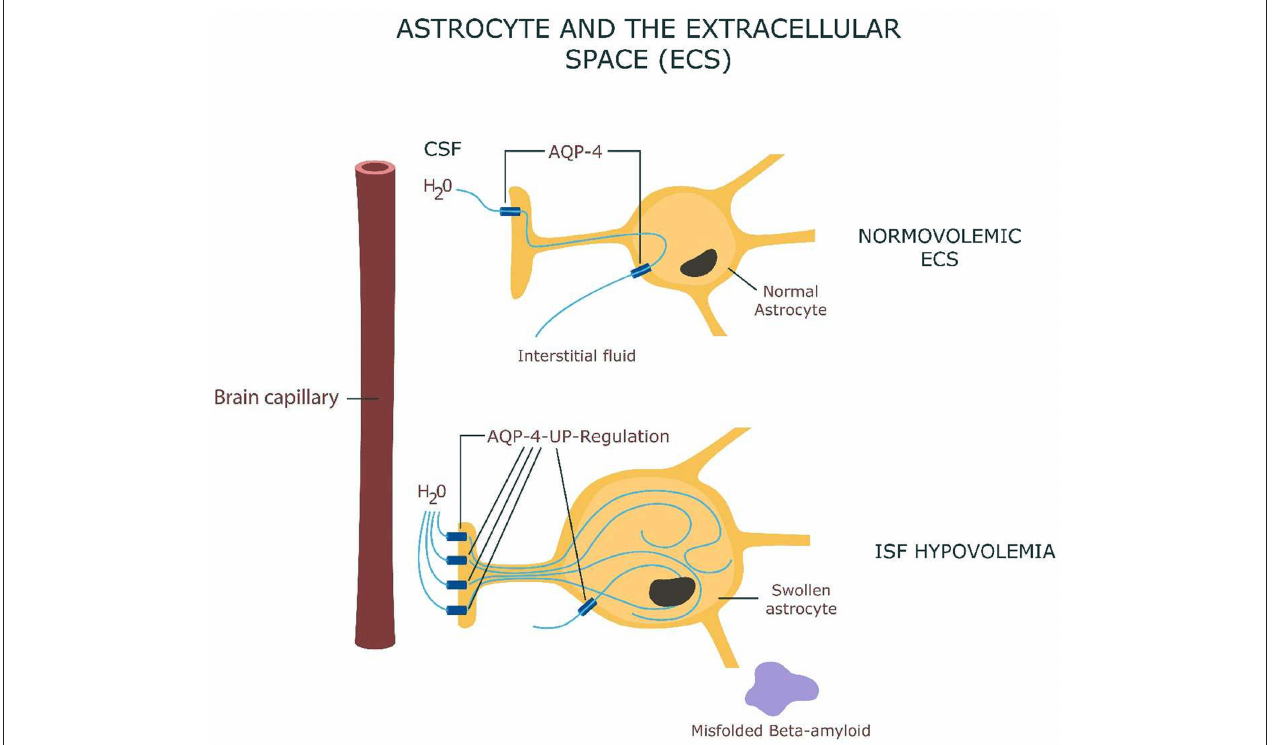
FIGURE 1 | Astrocyte swelling as a result of AQP-4 channels up-regulation with interstitial fluid hypovolemia and beta-amyloid misfolding.